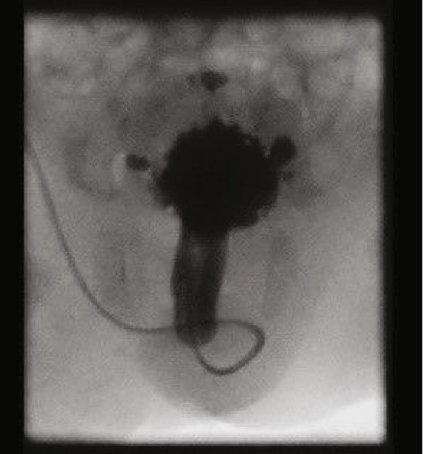
Figure 4: Dilated posterior urethra and a trabeculated urinary